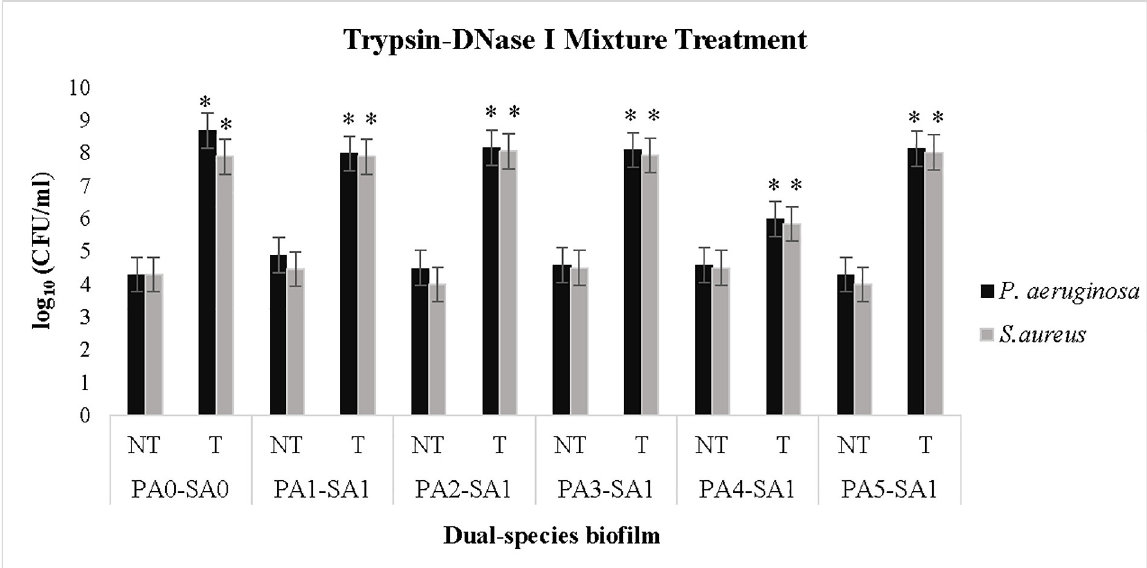
Fig 4. Effect of the trypsin/DNase I mixture on S . aureus-P . aeruginosa biofilms. Combination of 0.15 μ g/ml trypsin and 50 U/ml DNase I enzymes was treated on established S . aureus-P . aeruginosa biofilms in WLM. The mixture degraded all biofilms completely and dispersed bacterial cells. Data show the logarithm of CFU/ml of biofilm-released cells. Asterisks indicate the statistically significant difference ( p < 0.05) in the number of released bacteria from treated biofilms compared to non-treated (control) biofilms. The data shown are the mean ( ± standard error of the mean) of at least three replicates (three independent experiments). Abbreviation: NT, Non-treated; T, Treated; PA 0 , PA ATCC 27853; PA 1 , PA1185; PA 2, PA1179; PA 3, PA1162; PA 4, PA1326; PA 5, PA1329; SA 0 , SA ATCC 29213; SA 1 , SA639.